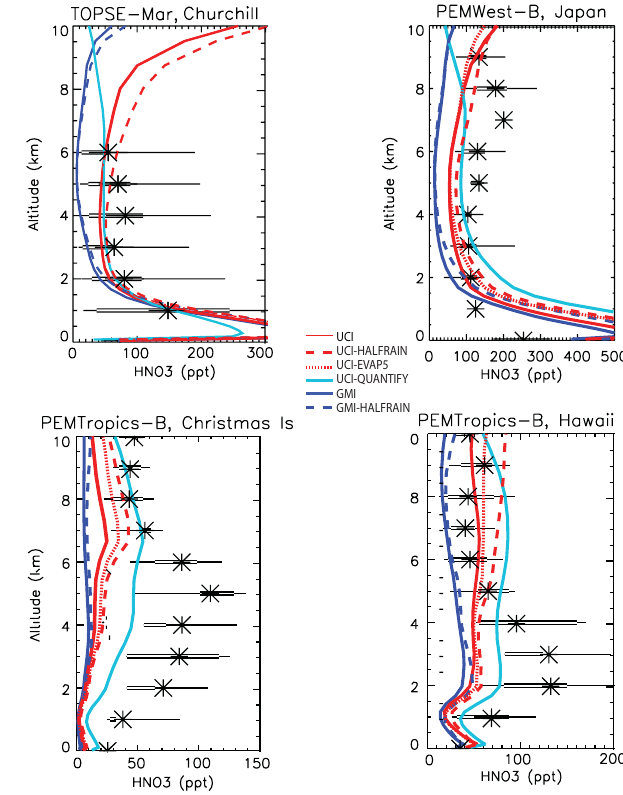
Fig. 9. Same as Fig. 2b, n, r, and u, but model profiles are for UCI (red solid), UCI-HALFRAIN (red dashed), UCI-EVAP5 (red dot- ted), UCI-QUANTIFY (cyan), GMI (blue), and GMI-HALFRAIN (blue dashed), and the range of the x-axis has been decreased to highlight the differences between the